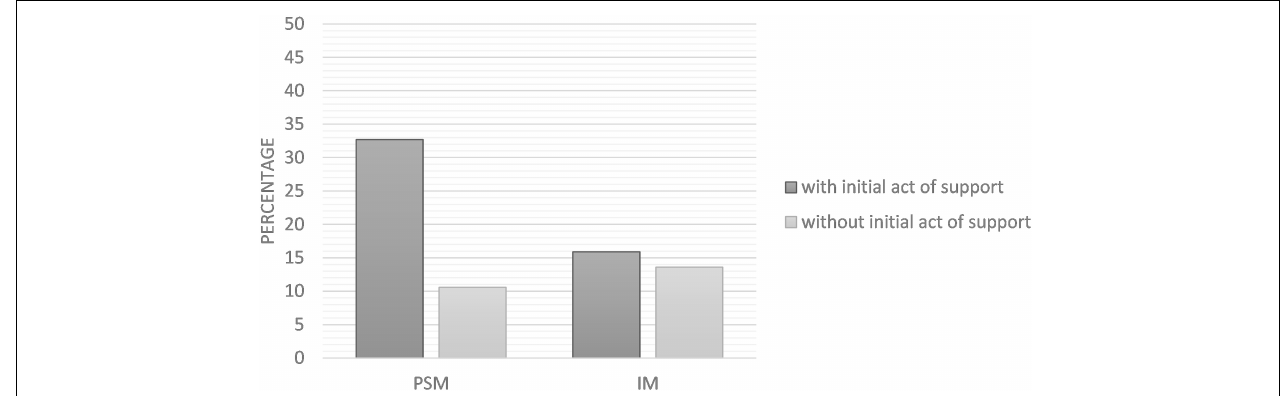
FIGURE 2 | Percentages of volunteering acceptance according to experimental conditions (Study